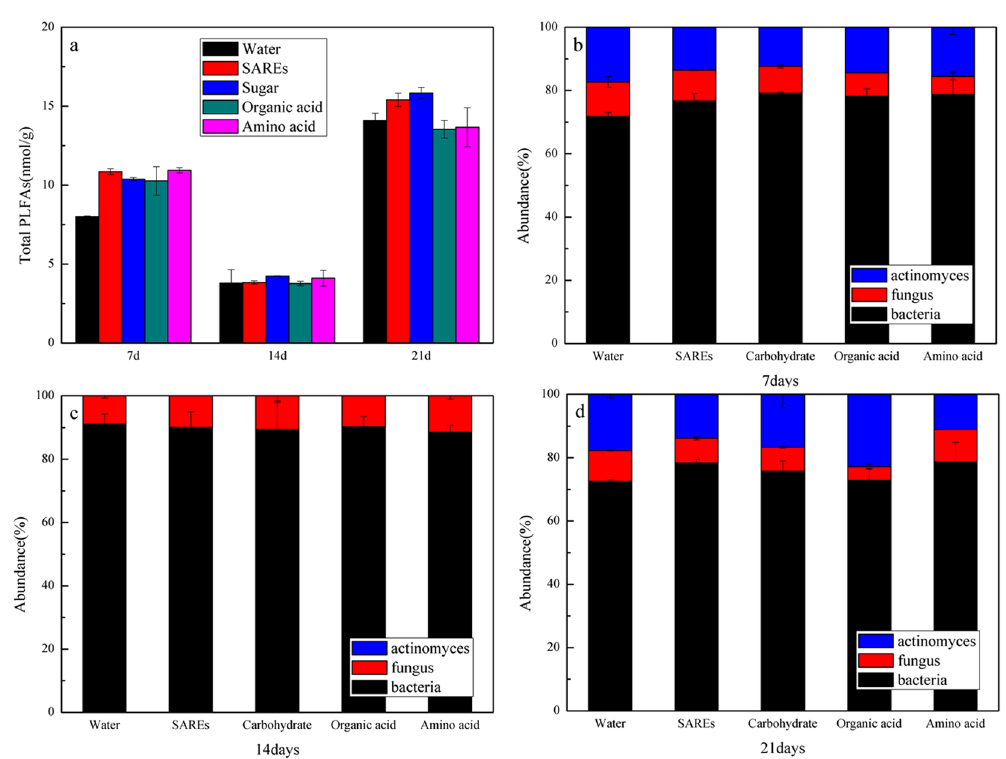
Figure 3. Effect of root exudate components on microbial biomass changes ( a ) and the microbial communities of bacteria, fungi and actinomycetes in different cultivation times, 7 days ( b ), 14 days ( c ) and 21 days ( d